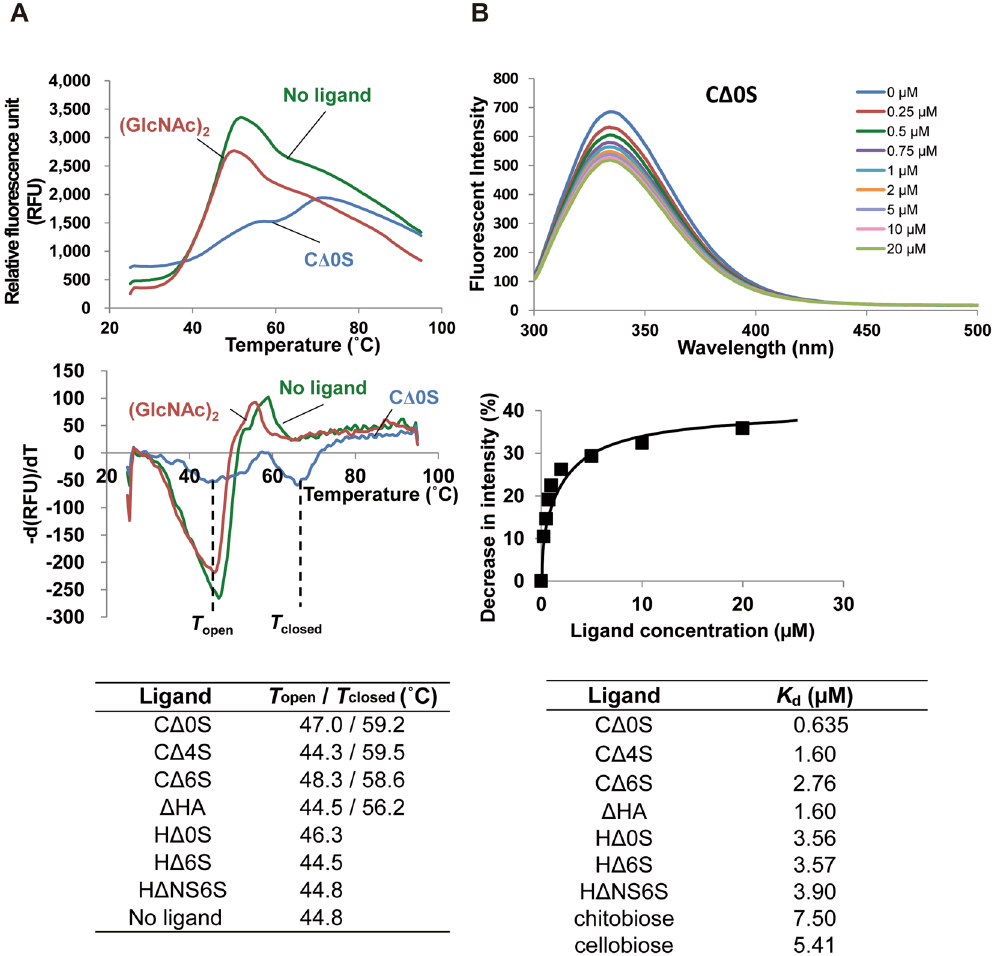
Figure 5. Affinity of Smon0123 with unsaturated GAG disaccharides. ( A ) DSF analysis. Upper, fluorescence profile of Smon0123 with C ∆ 0S (green: 0 mM and cyan: 1 mM) or 1 mM N , N ′ -diacetylchitobiose (red). Middle, negative derivative curve plot derived from the fluorescence profile. Lower, the values of T open and T closed in the presence or absence of various unsaturated GAG disaccharides. ( B ) Fluorescence spectrum analysis. Upper, wavelength-scanned fluorescence intensity of Smon0123 with C ∆ 0S (blue: 0 μ M; red: 0.25 μ M; green: 0.50 μ M; purple: 0.75 μ M; cyan: 1.0 μ M; orange: 2.0 μ M; lilac: 5.0 μ M; pink: 10 μ M; and olive: 20 μ M). Middle, the relative fluorescence intensity by addition of increasing ligand concentrations was plotted after modification based on volume change in the cuvette. K d was determined using the least-squares method. Lower, dissociation constants of Smon0123 with various unsaturated GAG disaccharides. Chitobiose, N , N ′